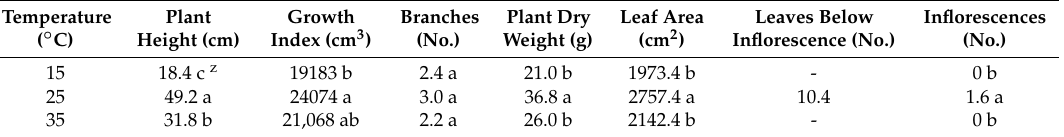
Table 2. The effects of temperature on plant height, plant growth index, number of branches, plant dry weight, leaf area, number of leaves below inflorescence and number of inflorescences per plant in red firespike ( Odontonema strictum